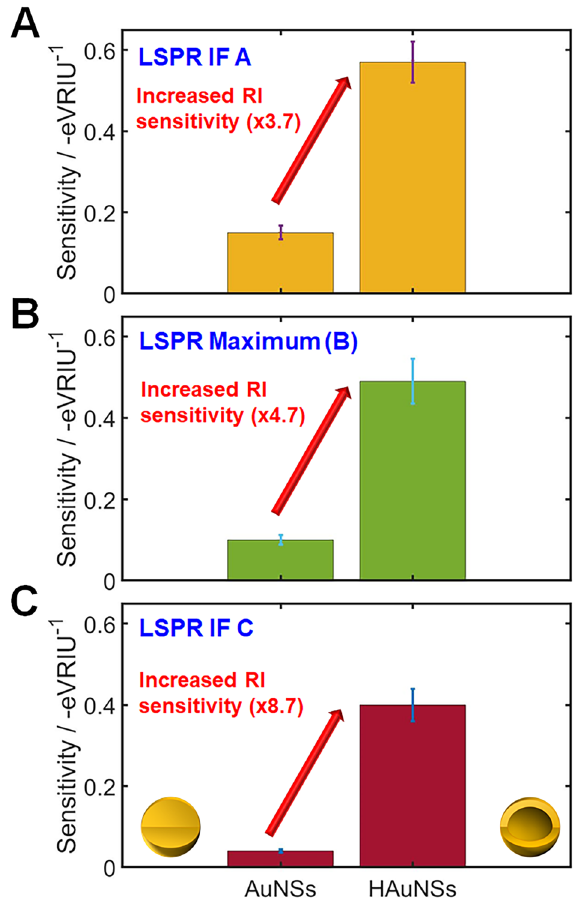
Figure 6. A comparison of RI sensitivity in ( A ) LSPR IF A at the long wavelength side, ( B ) LSPR peak maximum, ( C ) LSPR IF C at the short wavelength side, for solid AuNSs (left) and HAuNSs